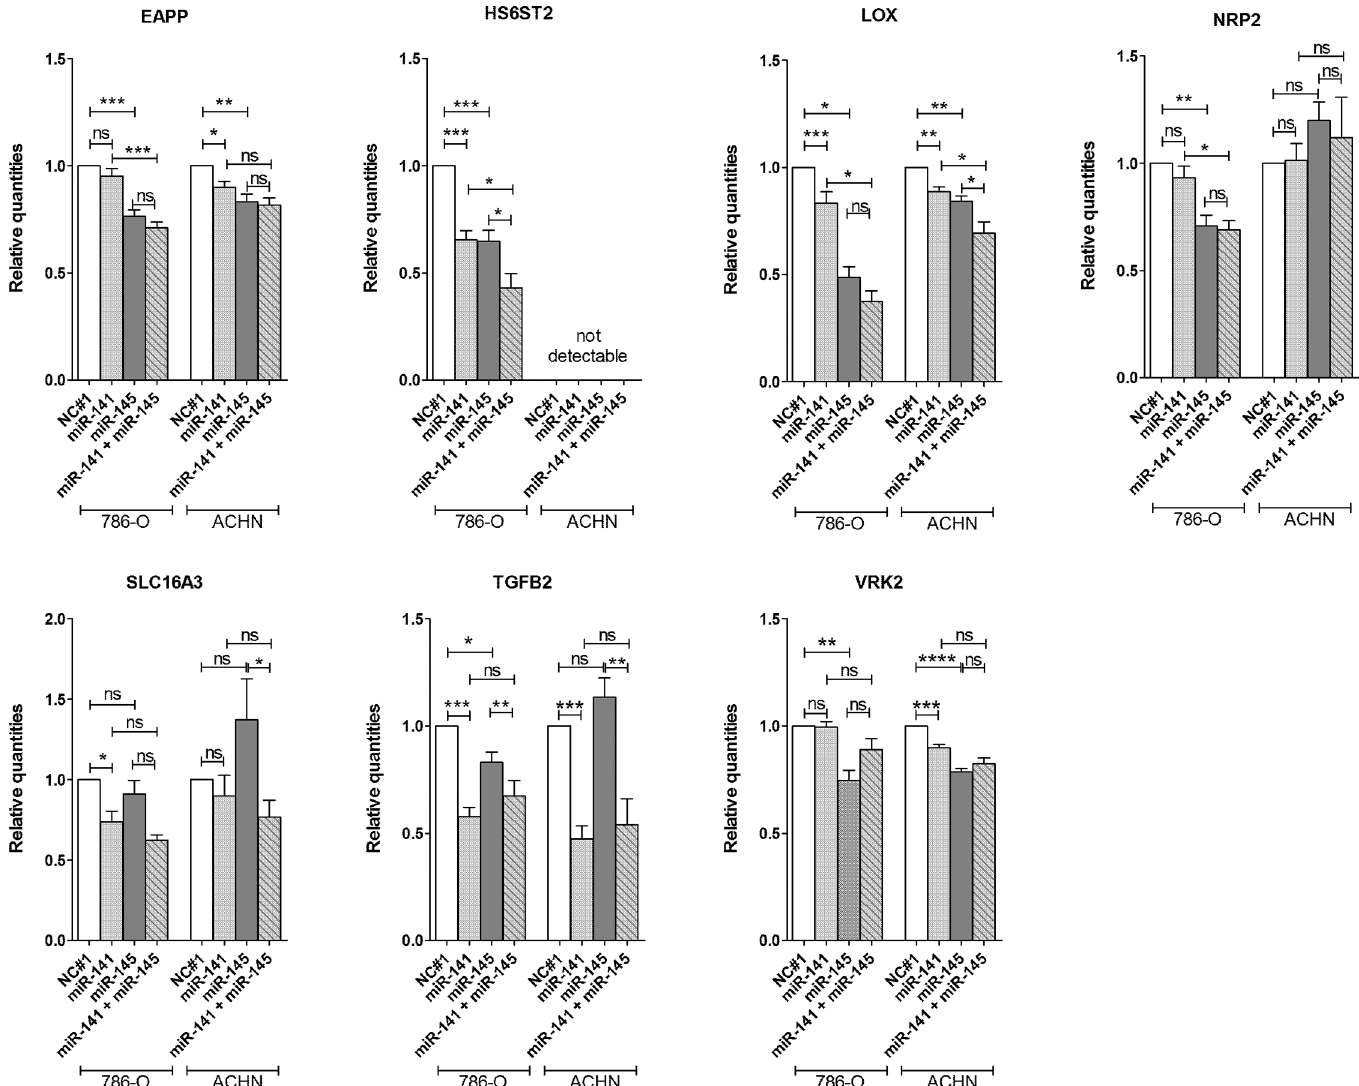
Fig 2. Effect of miRNA overexpression on target expression. MiR-141-3p and/or miR-145-5p were overexpressed in renal cancer cell lines 786-O and ACHN for 48 h. Effect on mRNA expression of putative targets, which were predicted to be regulated by miR-141-3p and miR-145-5p, was determined by RT- qPCR. Data are shown as mean ( ± SEM) relative to NC#1. NC#1 = negative control, n = 3, student ’ s t-test (two-tailed); * p < 0.05; ** p < 0.01; *** p < 0.001; **** p < 0.0001; ns = not